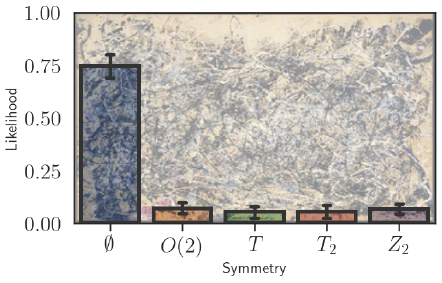
Figure 7: Work by Pollock Number 1, 1948 and the algorithm output.